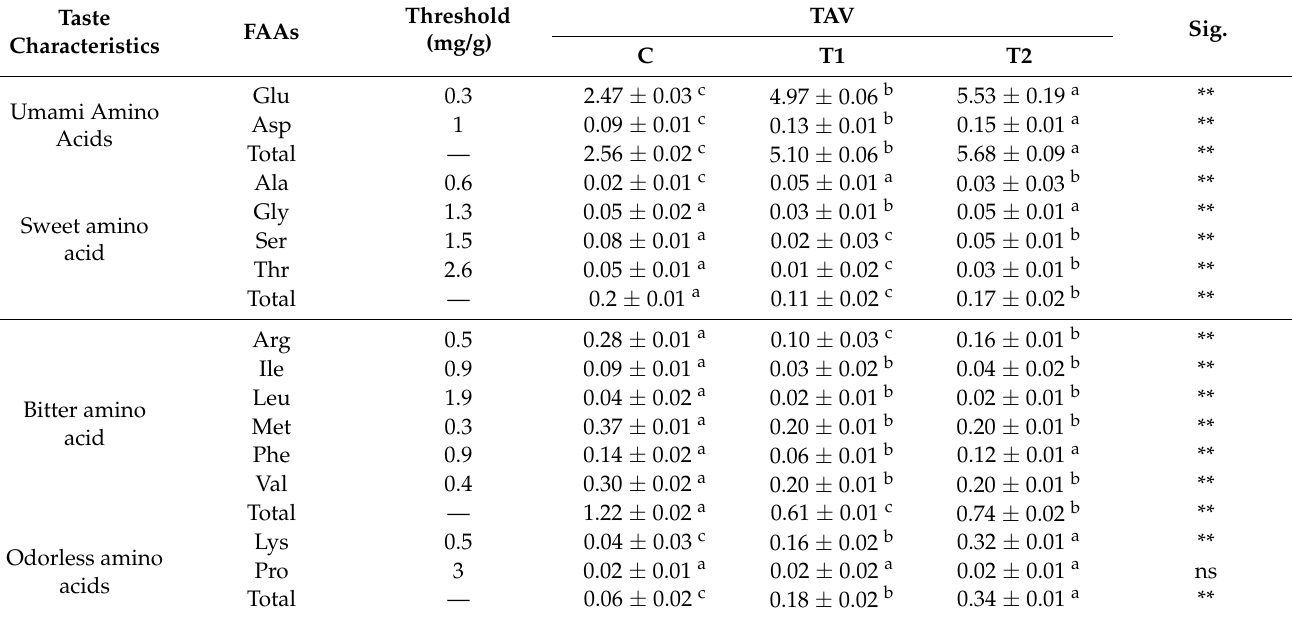
Table 5. The FAAs TAV of MPR with different process